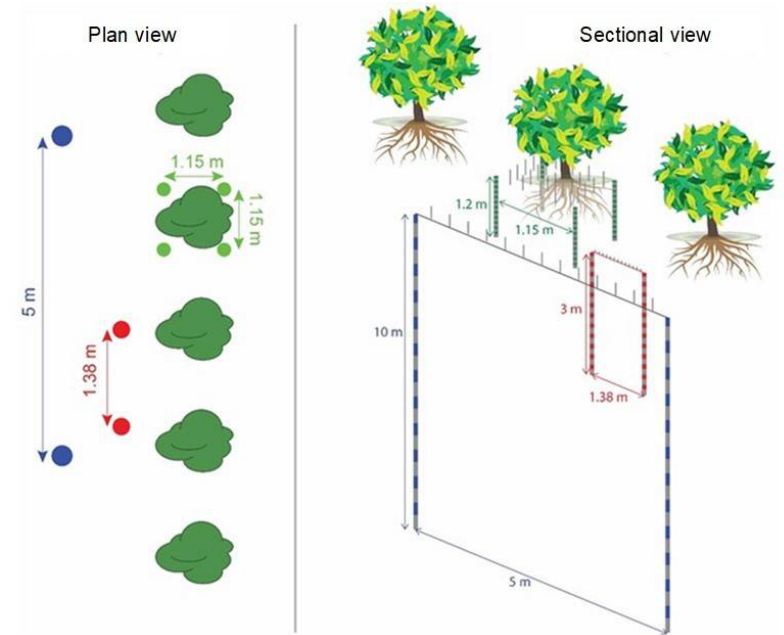
Figure 4. Schematic illustration of the electrical resistivity tomography (ERT) monitoring system established at the San Giuseppiello experimental site (located in the municipality of Giugliano near Naples, Italy; see the blue dot in Figure 1). The plan view shows the locations of the three different systems of electrodes for periodic downhole ERT surveys. The sectional view shows the depths reached by each borehole.